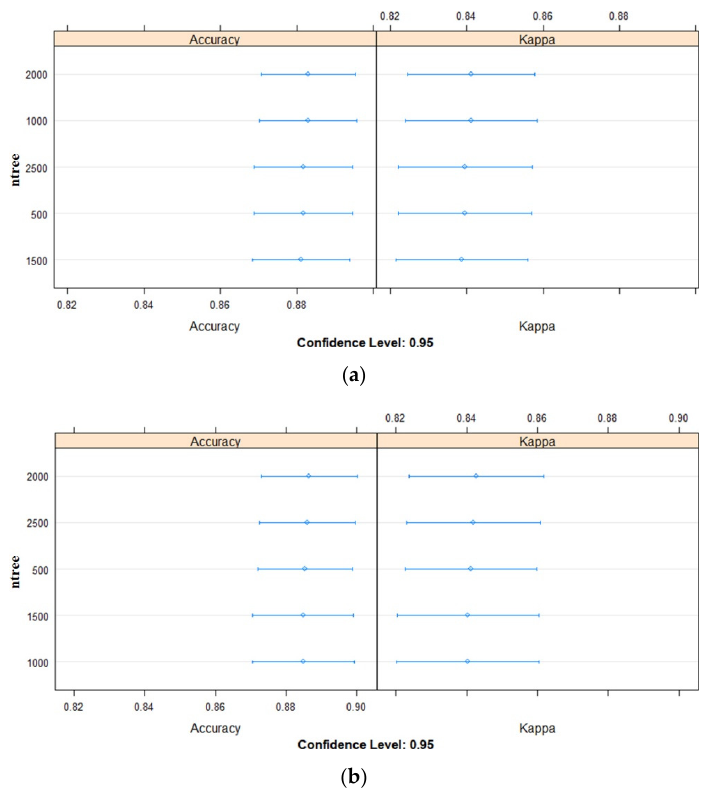
Figure A1. Dot plot of the accuracy and Kappa in 95% confidence interval obtained by using various ntree for tuning random forest (RF) model: ( a) for 2010 LC map ( b ) for 2020 LC map.